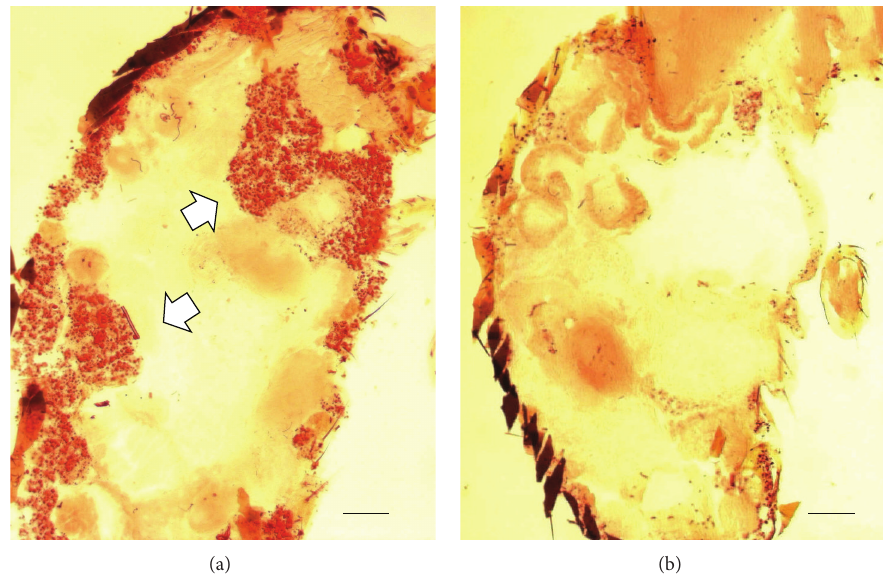
Figure 1: Effect of total Pdp1 RNAi induced in adult Drosophila on lipid staining. Flies were injected with control dsRNA (panel (a)) and dsRNA targeted at a sequence common to all known Pdp1 isoforms (total Pdp1 RNAi; panel (b)). They were processed for lipid staining (red) five days later. Shown is a low magnification (objective 5x) sagittal abdominal section (size bar = 150 𝜇 m). Note the presence of lipid staining in the fat tissue cells of a control fly (indicated by white arrows) (a) and its absence in the Pdp1 RNAi fly